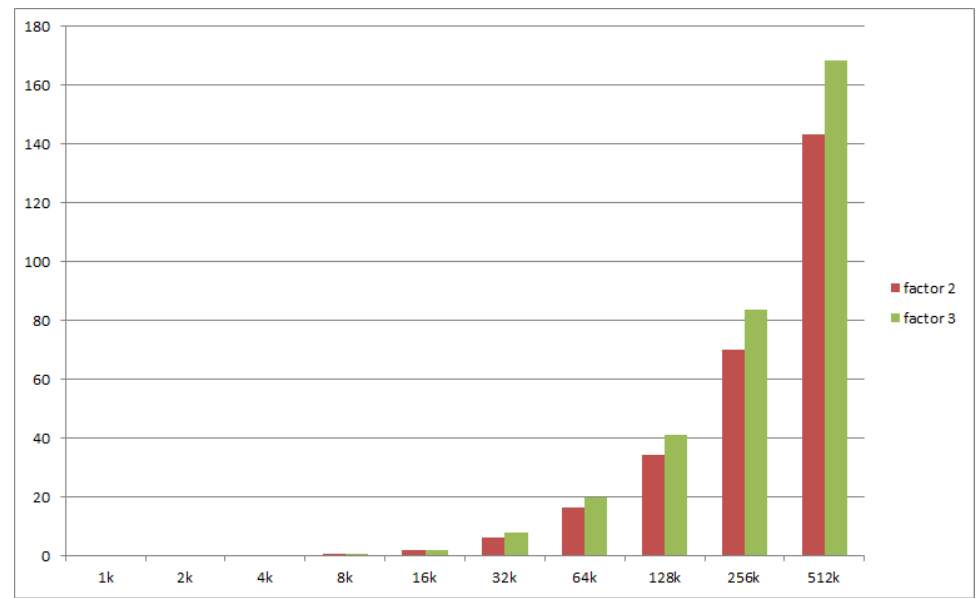
Figure 13. Election of new master for unavailable objects.